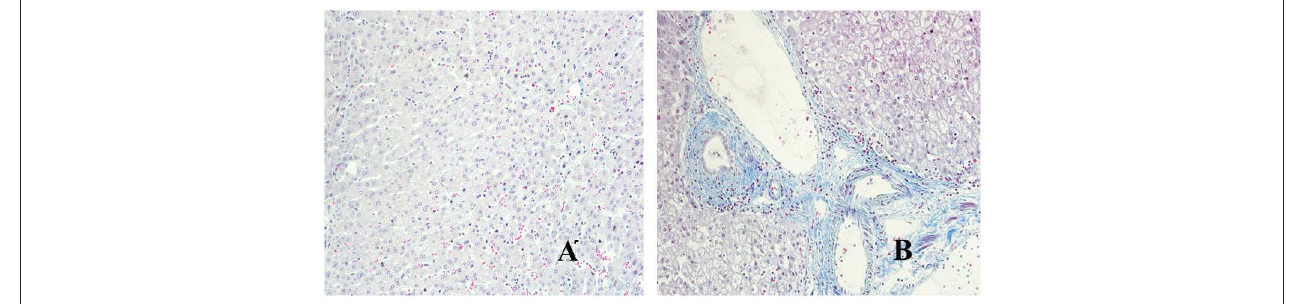
FIGURE 3 | Masson staining of liver lesions in patients with hepatic AE (magnification, × 200). (A) Distance group. (B) Close group.